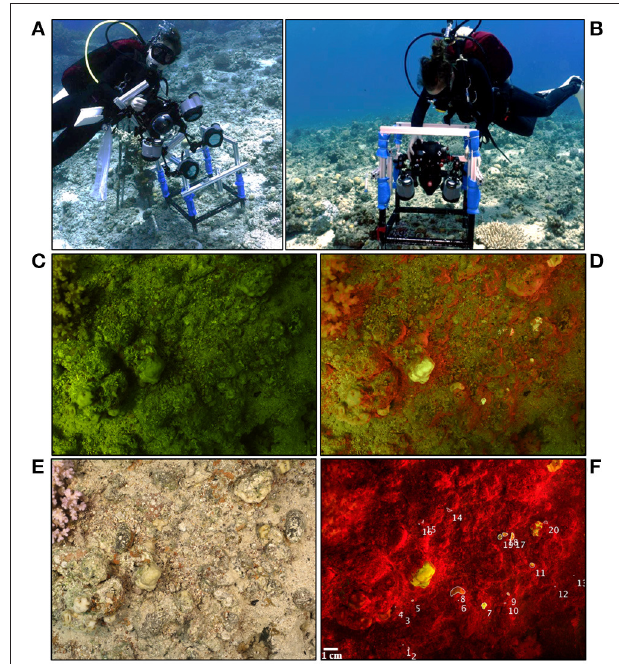
FIGURE 1 | (A) A diver attaching the FluorIS to a custom-made frame in order to (B) image co-located image pairs (ambient and fluorescence) after positioning the frame. (C) Ambient image (blue strobes off) and (D) Fluorescence image (blue strobes on) taken using the FluorIS. (E) Reflectance image taken under white illumination with a standard camera. All images were taken during daytime at the Inter University Institute (IUI), Gulf of Eilat, Israel at 8m depth. Quadrat size is 20 × 20cm. (F) Fluorescence image after subtracting image (C) from image (D) . Numbers represent coral recruits marked using the MATLAB code developed for this